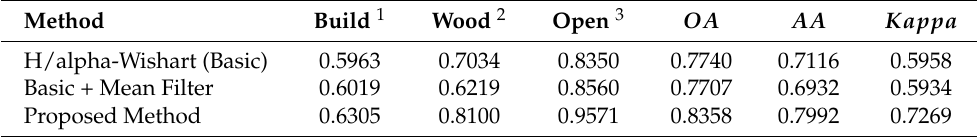
Figure 9. Confusion matrix of thhe H/alpha-Wishart method and VQC-CAE model. The categories from the first row to the third row are built-up area, wood land and open area. The blue gradient arrow on the right represents the difference of confusion matrix element values from 0 to 10 6 ; the larger the matrix element value, the darker the color. The larger the value of the non-diagonal element in the confusion matrix, the easier it is to classify pixels from other categories into this category. The larger the diagonal element, the smaller the misclassification of the category. Table 3. Comparison of the classification accuracy of our approach with other